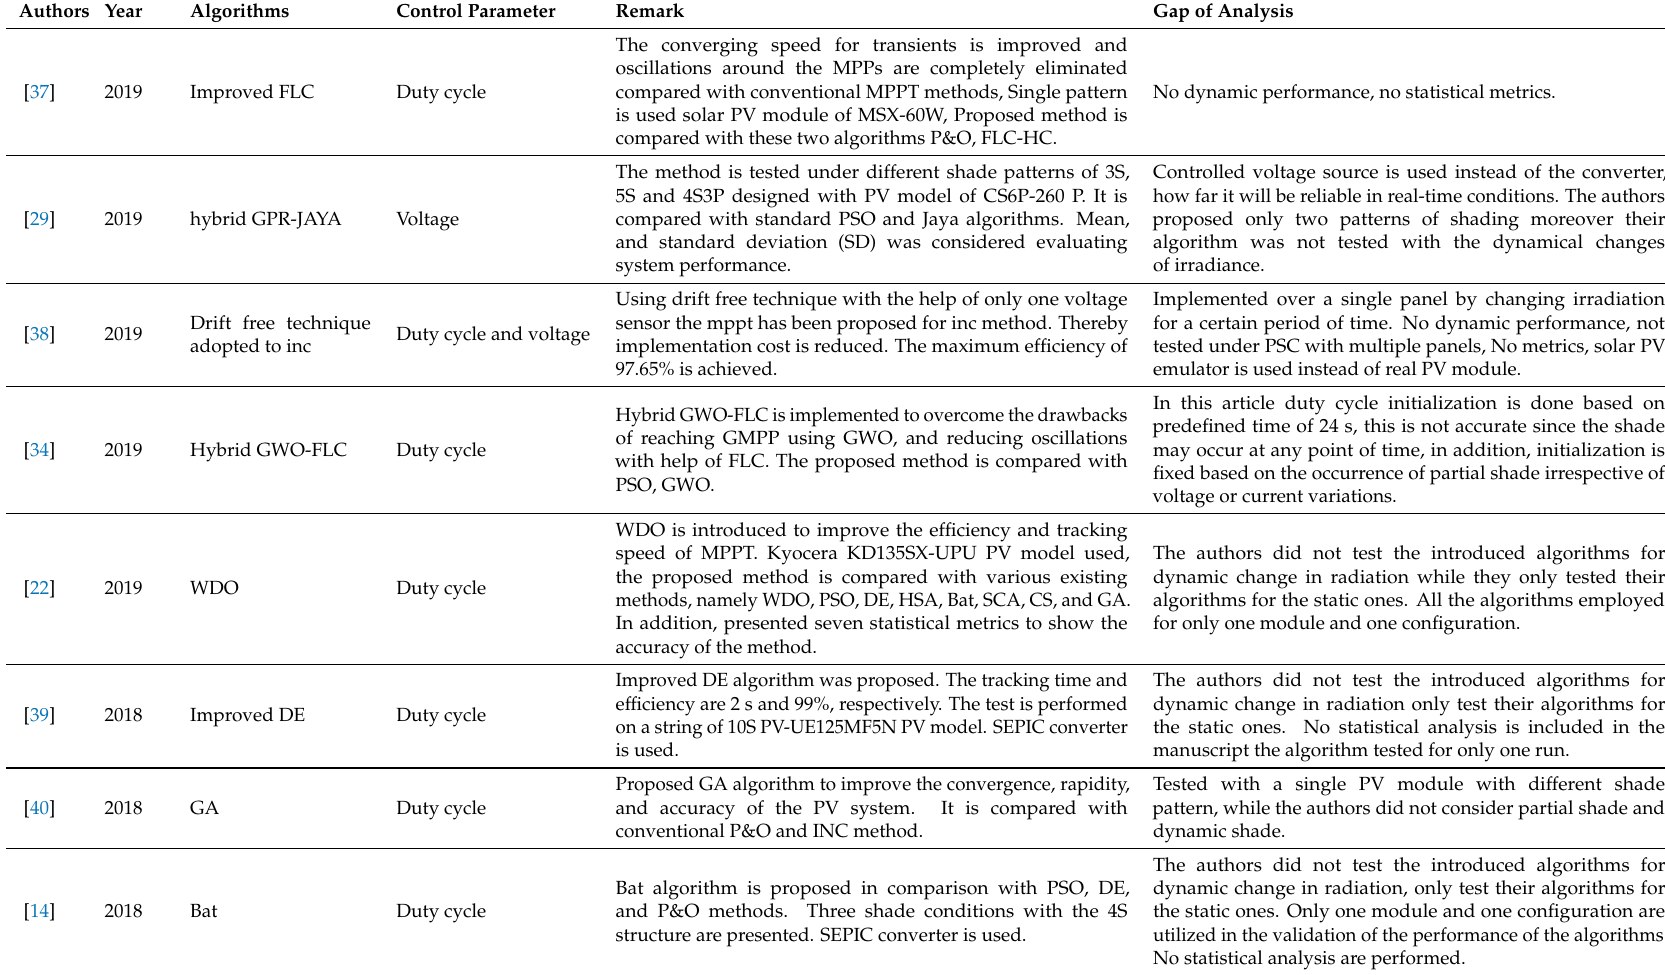
Table 1. Research gaps and noticeable remarks on recent published MPPT